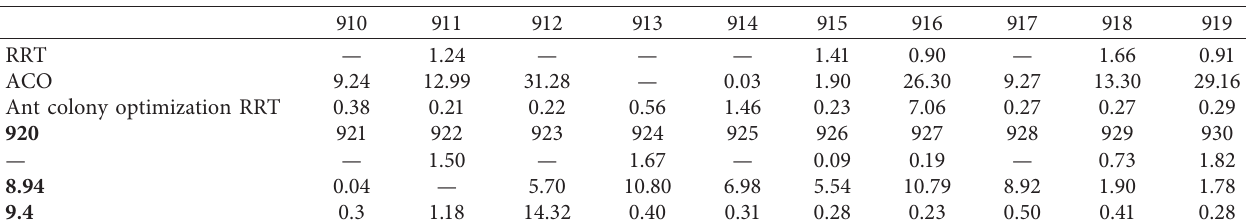
Figure 8: The time required for the three algorithms to find the path with a length of 900 to 930 in map 4.